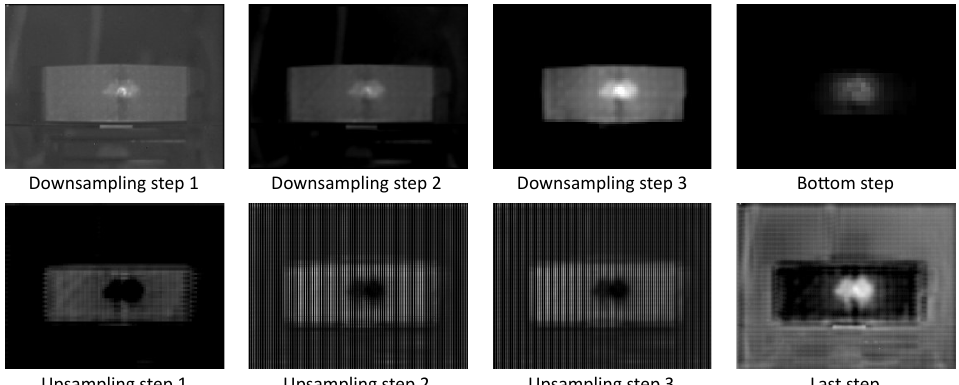
Figure 9. Layer activation maps of a trained deep model for MWIR data.